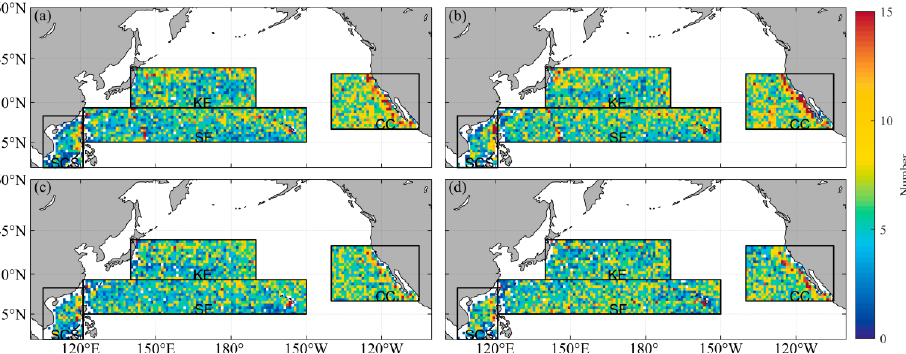
Figure 9. Number of eddy generation. AEs and CEs detected by the META dataset are given in ( a ) and ( b ), respectively. Identically, AEs and CEs detected by the GOMEAD dataset are given in ( c ) and ( d ), respectively.